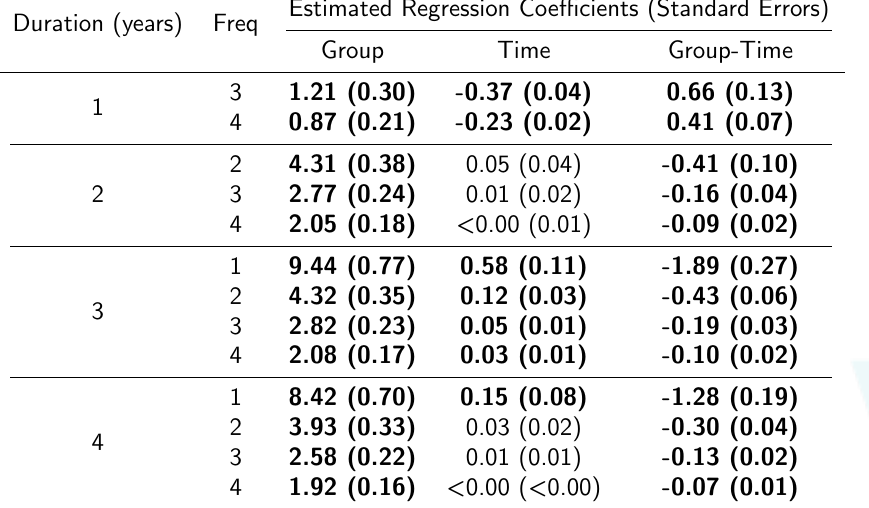
Table 2: Estimated regression coefficients (standard errors) for a generalized linear model applied to administrative data for com- binations of study duration and frequency of outcome measurements per year; model contained coefficients to estimate the linear trend over